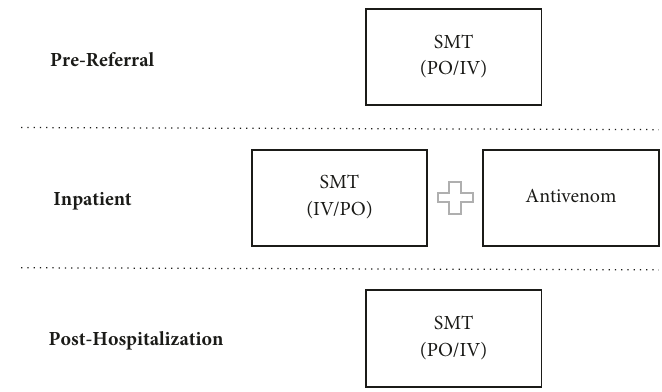
Figure 1: Potential uses of an SMT, via PO (oral), or IV (intravenous).